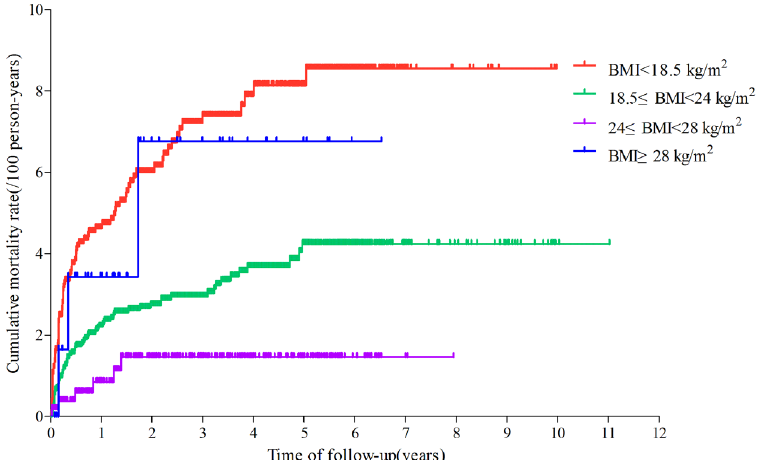
Figure 2. Cumulative mortality rates of patients in the different BMI groups. Figure 2 shows that the cumulative mortality rate in the underweight group was significantly higher than that in the overweight and normal-weight groups and that the mortality rate in the obese group was higher than that in the normal-weight and overweight groups.